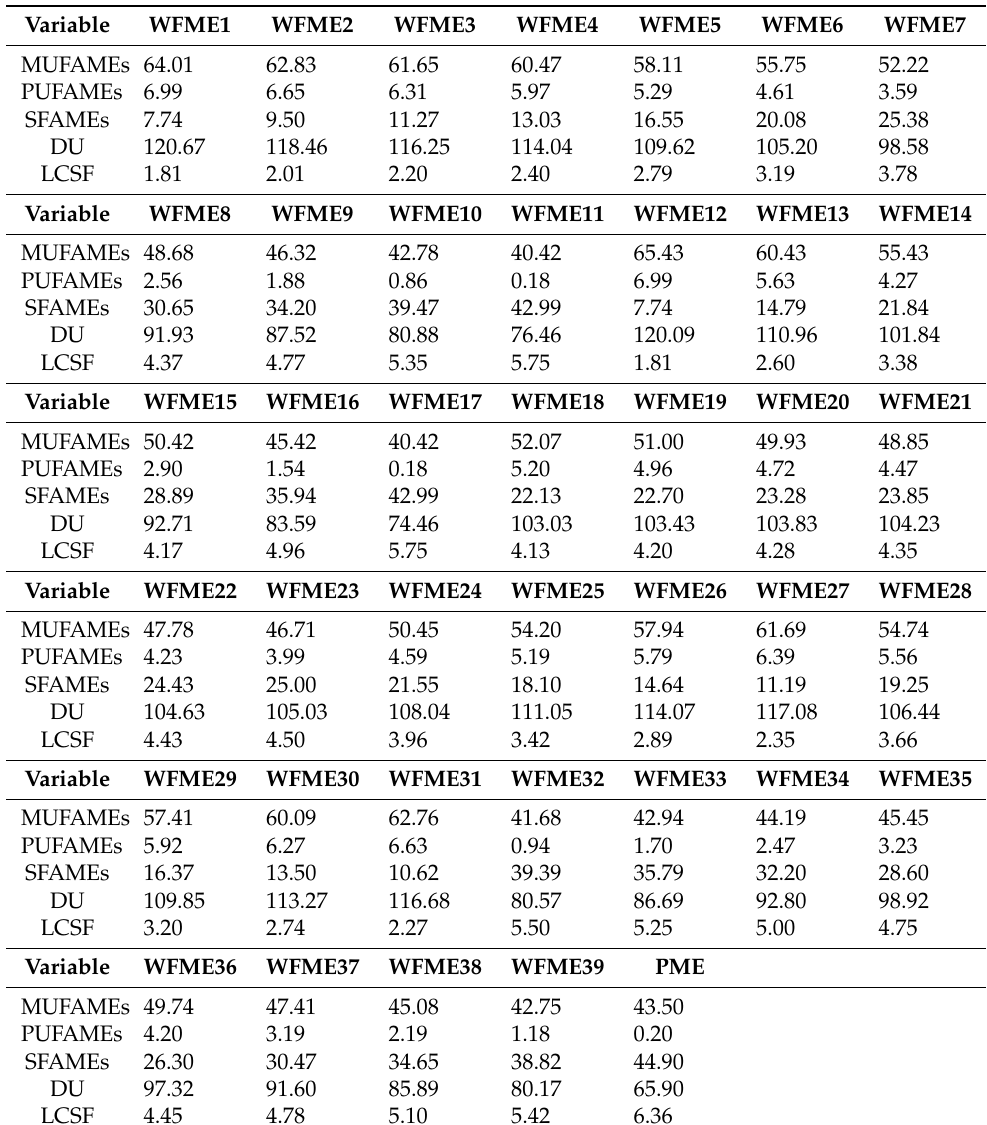
Table 1. Estimated values for MUFAMEs, PUFAMEs, SFAME, DU, and